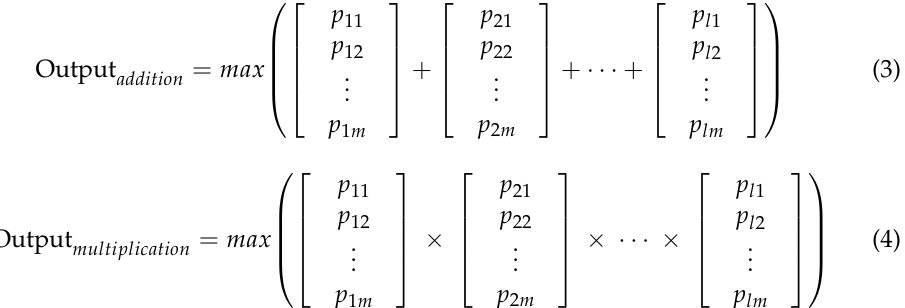
model. The addition and multiplication of the output score are defined by Equations (3) where l and m indicate the number of classification models and the number of classes, respectively. and (4), respectively.